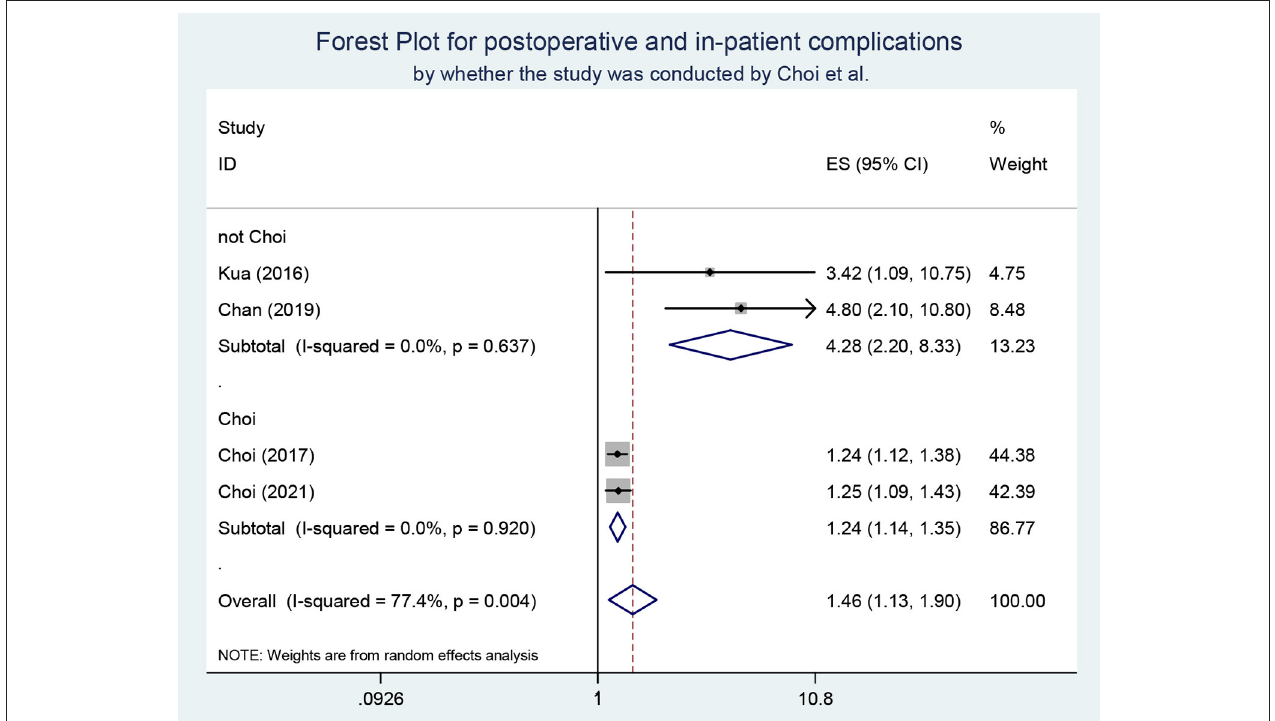
FIGURE 3 | Subgroup analysis for the studies reporting post-operative and in-patient